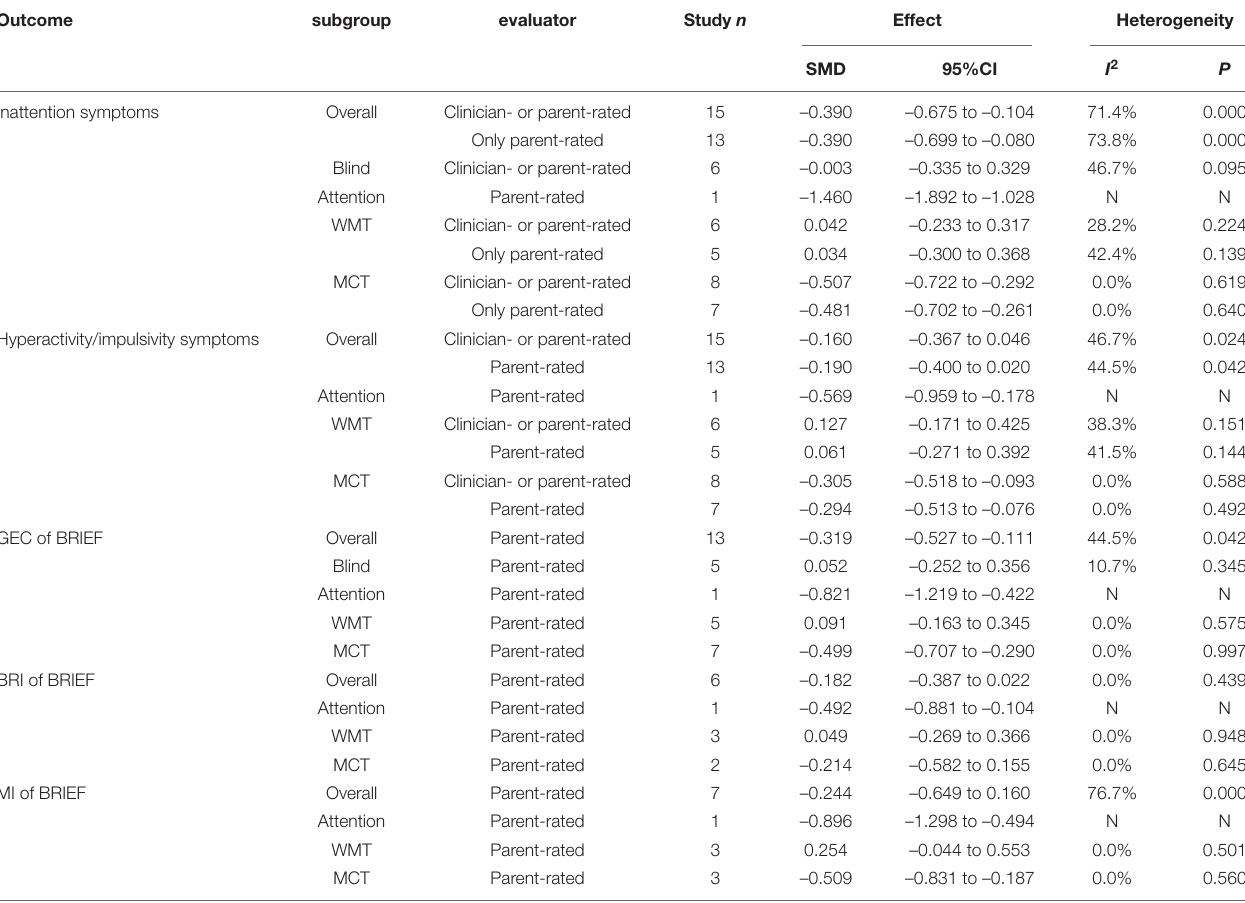
TABLE 2 | Summary of results showing pooled standardized mean differences (SMD) between treatment and control arms for each outcome.